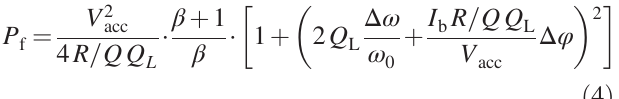
FIG. 6. Beam dynamics simulations for the once-recirculating ERL mode along the second recirculation beamline (done with ELEGANT [24]). (a) Mapping of the different sections to the simulation. (b) Beam envelope in horizontal ( S x ) and vertical ( S y ) direction. (c) Transversal and angular